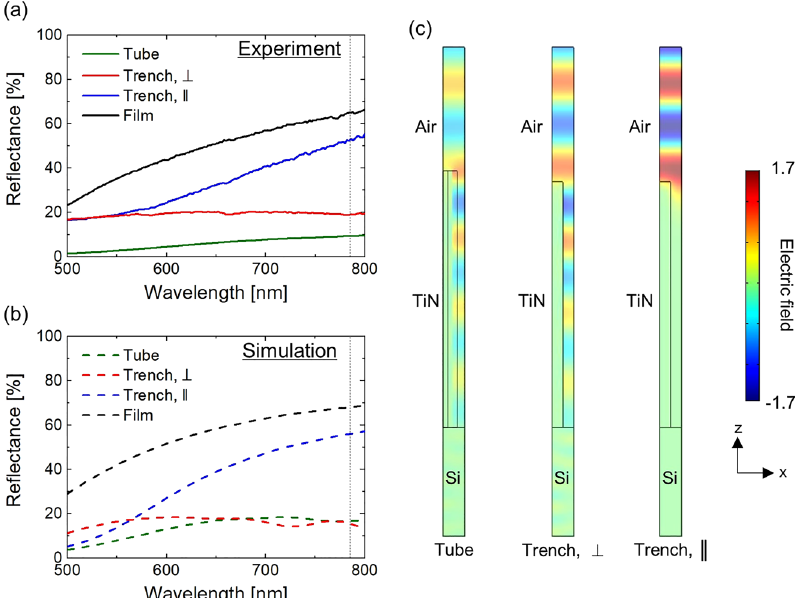
Figure 2: Reflectance of the samples from (a) UV – VIS measurements and (b) numerical simulations. The dashed line in each fi gure marks 785 nm in the wavelength scale. In the simulations, the incident fi elds were linearly polarized. (c) The cross-sectional electric fi eld maps in the x – z plane by irra- diatinglinearlypolarized lightat785 nmfor thetube,trench( ⊥ ),andtrench( || ).Onehalf of each period is shown. The color scale is common for the three fi eld maps and is normalized to the incident fi